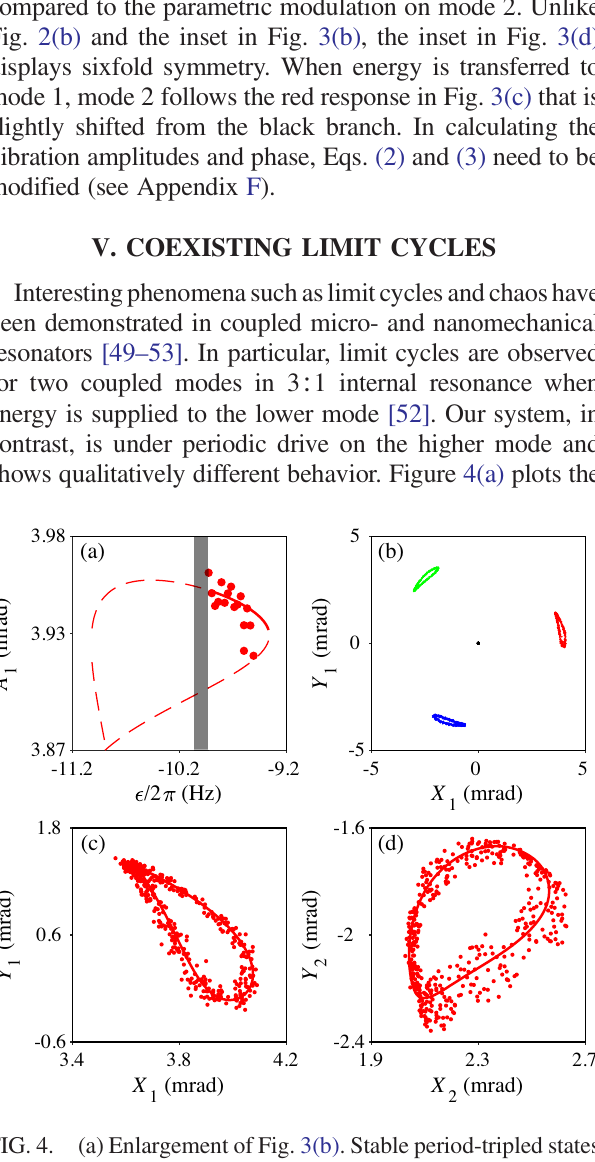
FIG. 4. (a) Enlargement of Fig. 3(b). Stable period-tripled states in mode 1 turn into limit cycles at the right end of the gray band. The limit cycles disappear at the left end of the gray band. (b) Three coexisting limit cycles in mode 1 are measured at frequency detune ϵ = 2 π of − 10 . 01 Hz. (c) Enlargement of the red limit cycle. The line represents calculations. (d) Corresponding data for mode